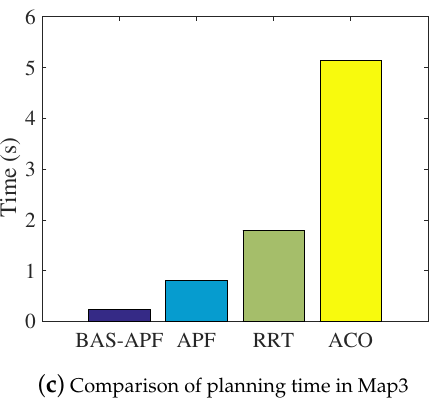
Figure 11. Comparison of planning time on simulative